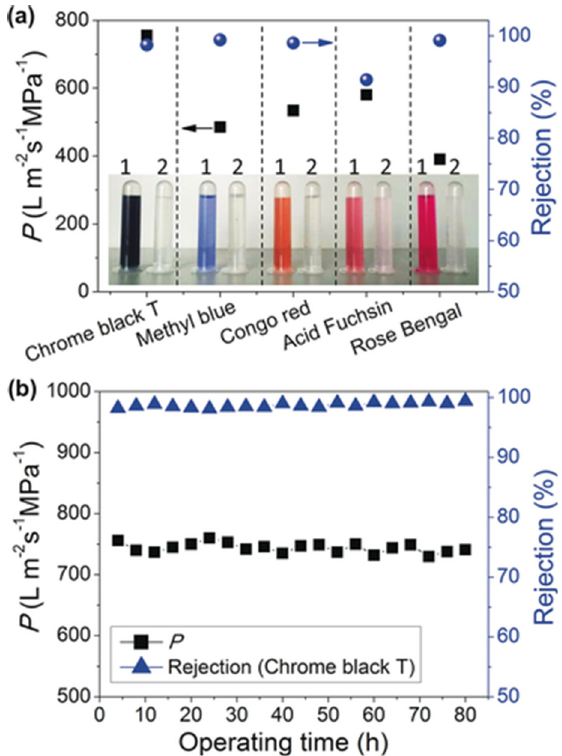
Figure 26. ( a ) Water permeance and rejection rates of the tubular COF-LZU1 membrane in the nanofiltration of different dyes (photographs show the colours of the dye solutions before (1) and after (2) NF). ( b ) Stability test of the tubular COF-LZU1 membrane in a long-time NF of chrome black. Operating pressure: 0.5 MPa; dye concentration: 100 mgL − 1 ; room temperature. Reprinted with permission from [78], Copyright (2018) John Wiley and Sons publications.